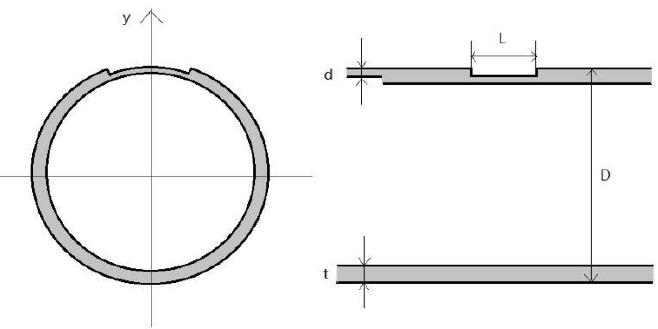
Energies 2022 , 15 , x FOR PEER REVIEW Figure 10. Schematic illustration of corroded pipe. Figure 10. Schematic illustration of corroded pipe.